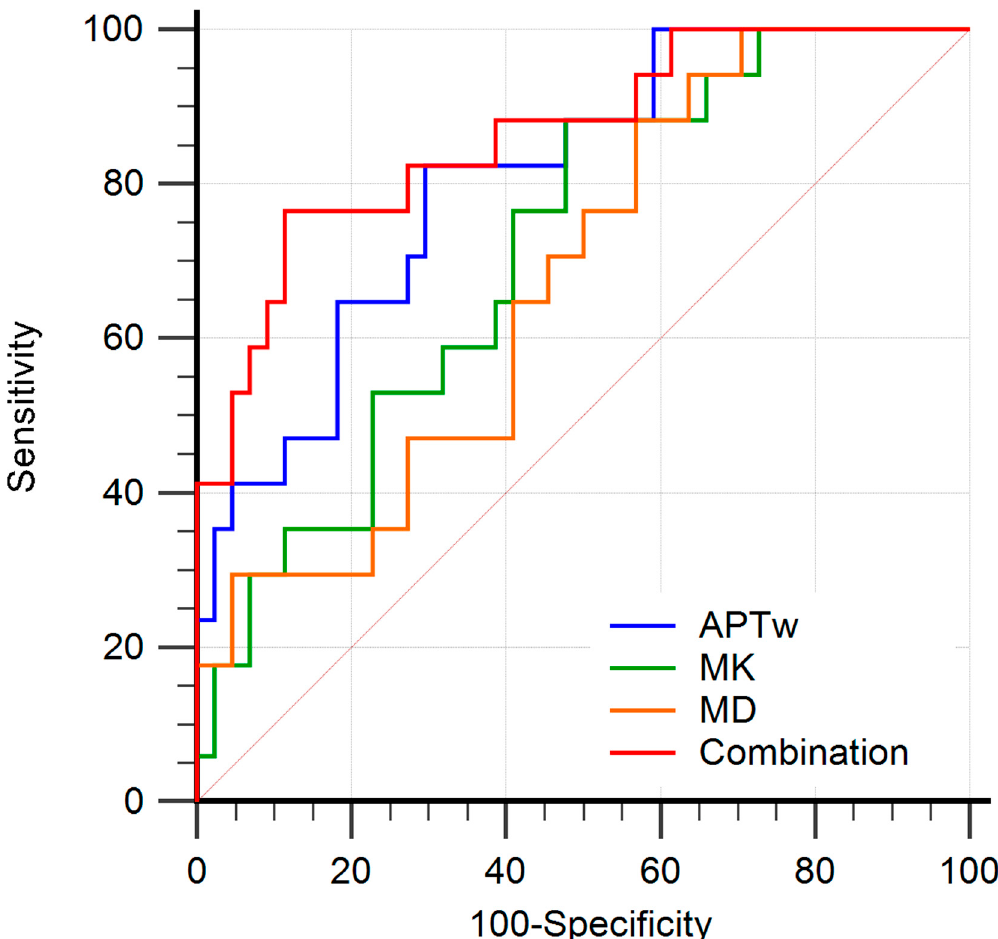
Figure 6. Receiver operating characteristic curves (ROC) analysis of each parameter for predicting the LNM in patients with cervical cancer. The area under curves (AUCs) of amide proton transfer-weighted (APTw), mean kurtosis (MK), mean diffusivity (MD) values, and combination model (APTw + MK + MD) to evaluate LNM status were 0.807 (95% CI: 0.686–0.897), 0.715 (95% CI: 0.585–0.823), 0.675 (95% CI: 0.543–0.790), and 0.864 (95% CI: 0.752–0.938), respectively. The combi- nation of APTw, MK, and MD yielded the highest AUC.